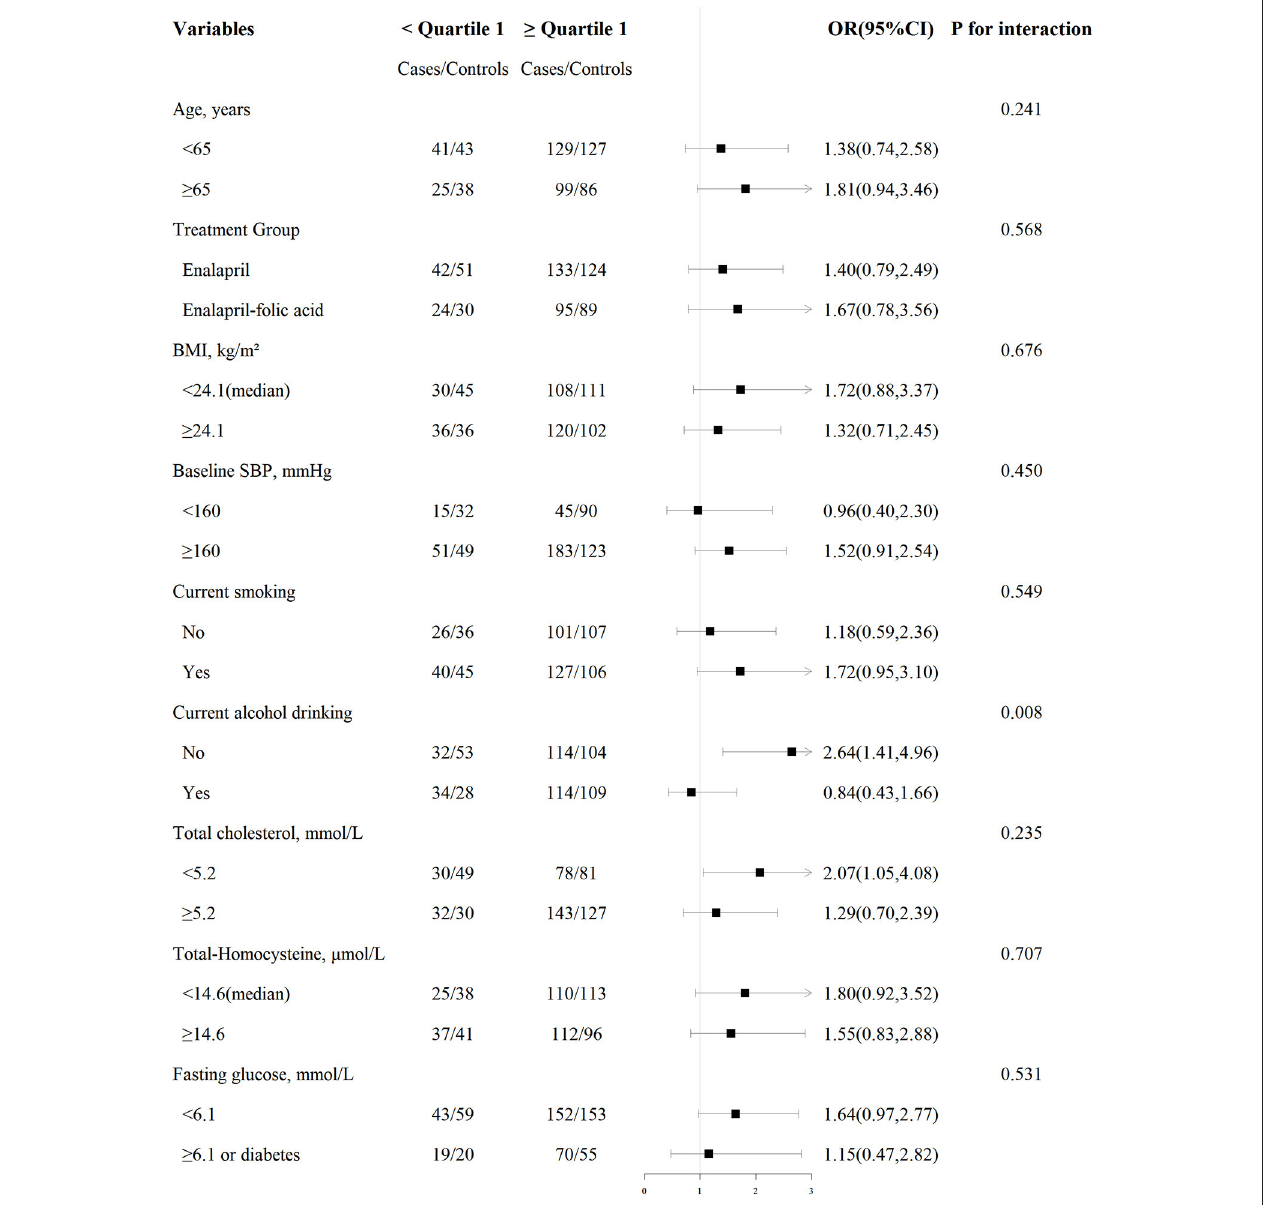
FIGURE 2 | Association between plasma vitamin E ( < quartile 1 vs. ≥ quartile 1) and risk of first total stroke among males in various subgroups. Each subgroup analysis adjusted, if not stratified, for age, treatment group, study site, body mass index (BMI), smoking status, alcohol drinking, systolic blood pressure at baseline (SBP), fasting blood glucose, total cholesterol (TC), triglycerides (TG), high-density lipoprotein cholesterol (HDL-C), total homocysteine (tHcy), folate, as well as estimated glomerular filtration rate (eGFR) at